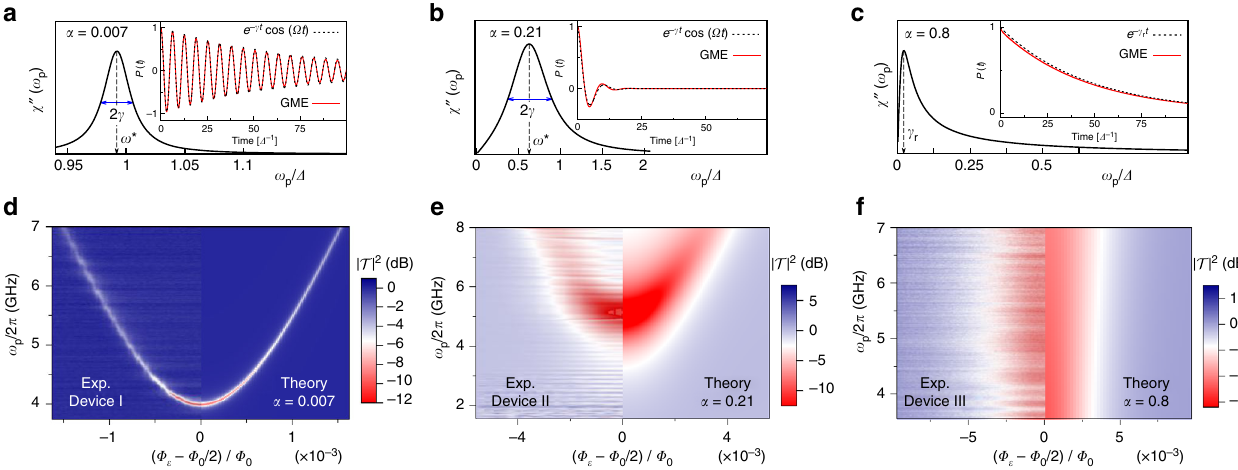
Fig. 2 Spin-boson dynamics and spectra at different coupling strengths in the absence of the drive. a – c Frequency dependence of the imaginary part χ ″ ( ω p ) of the linear susceptibility (a.u.) and time evolution of the population difference P ( t ) (insets) for the three selected combinations of coupling and ffiffiffiffiffiffiffiffiffiffiffiffiffiffiffiffiffiffiffi q temperature shown in Fig. 1c. The position ω * and FWHM 2 γ of the linear susceptibility peak in the coherent regimes ( α = 0.007, α = 0.21) provide a direct ω (cid:5) ð Þ 2 (cid:2) γ 2 measure of the renormalized qubit frequency Ω ¼ . In the incoherent regime ( α = 0.8), the peak position yields the relaxation rate γ r . d – f Experimental transmission spectra of three fl ux qubit devices with different coupling junctions are compared with spectra calculated within the NIBA. The characteristic hyperbolic spectrum of the fl ux qubit is evident in d and recognizable in e . Its disappearance in f indicates the transition to the incoherent regime. At Φ ε = Φ 0 /2 the spin-boson system is unbiased, which is the situation of panels a –